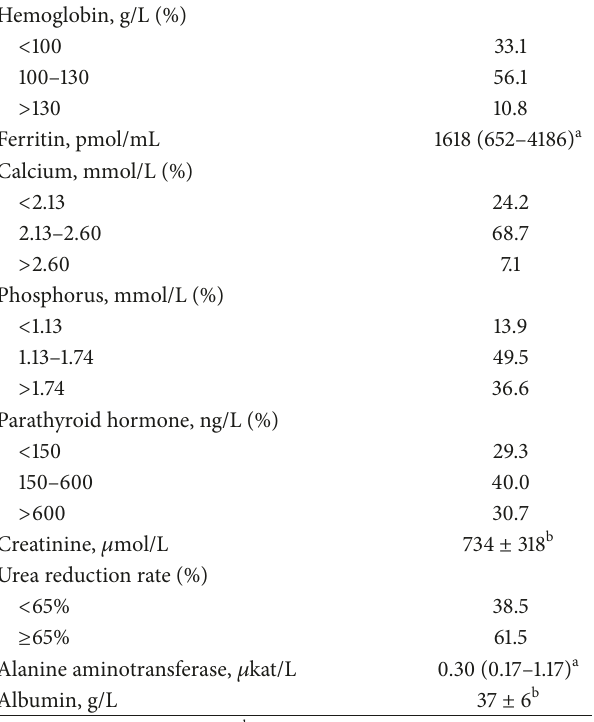
Table 5: Selected laboratory